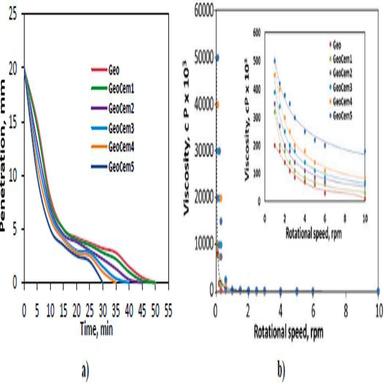
a) Setting time and b) Viscosity of geopolymer pastes produced by partial cement substitution to slag at S/L: 3.5 g/mL, 8 M KOH & 70 ◦C curing temperature.